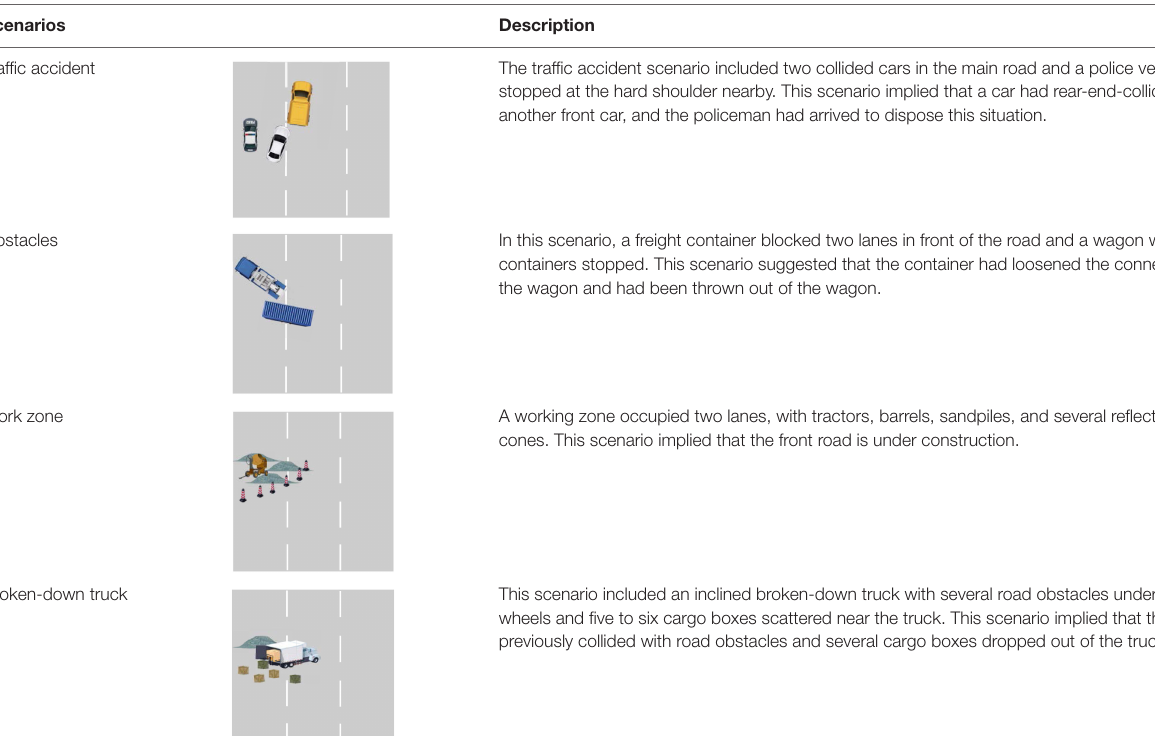
TABLE 1 | Takeover